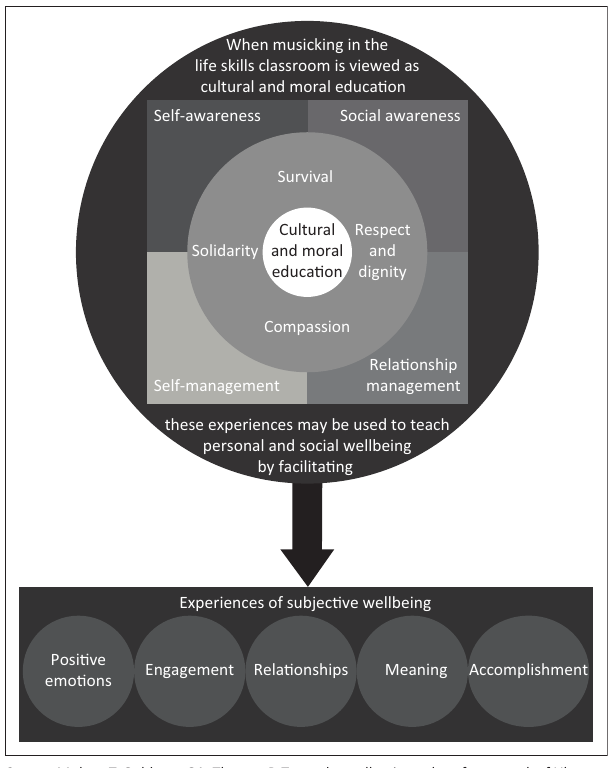
Posi(cid:27)ve Engagement Rela(cid:27)onships emo(cid:27)ons